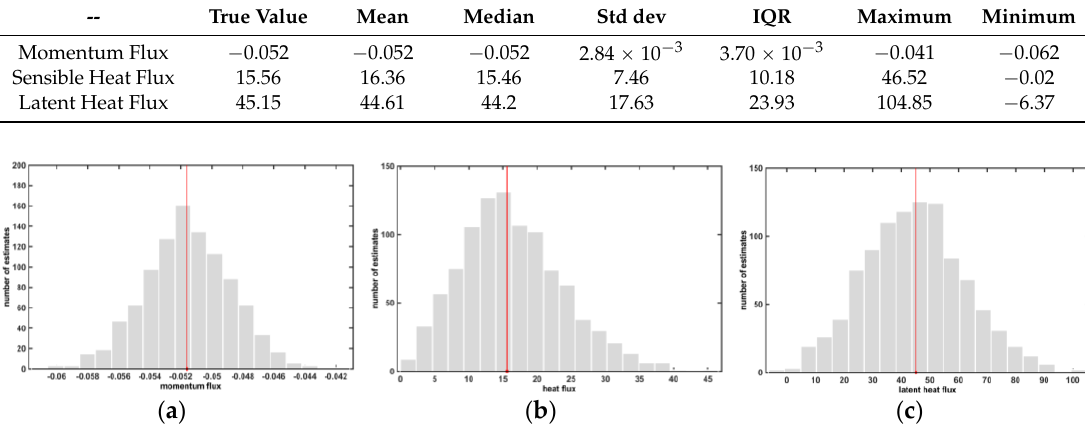
Table 3. Statistical characteristics of the fluxes. The units are the same as in Table 1.